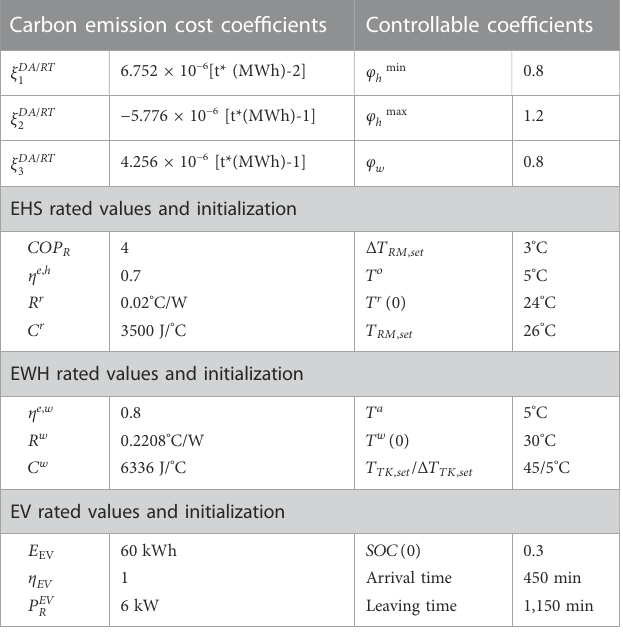
TABLE 2 Parameters and initialization of the proposed